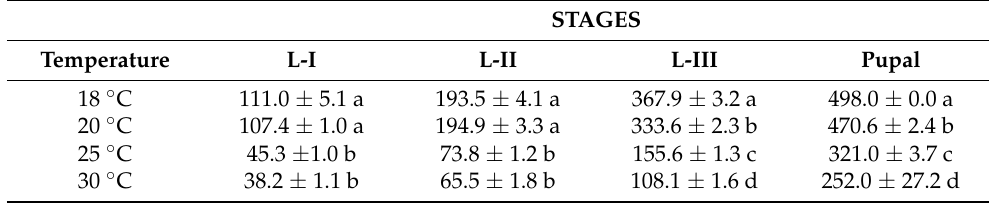
Table 1. Average duration (hours ± standard error, SE) for each preimaginal stage at different rearing temperatures. Different letters indicate statistically significant differences (LSD test, p <